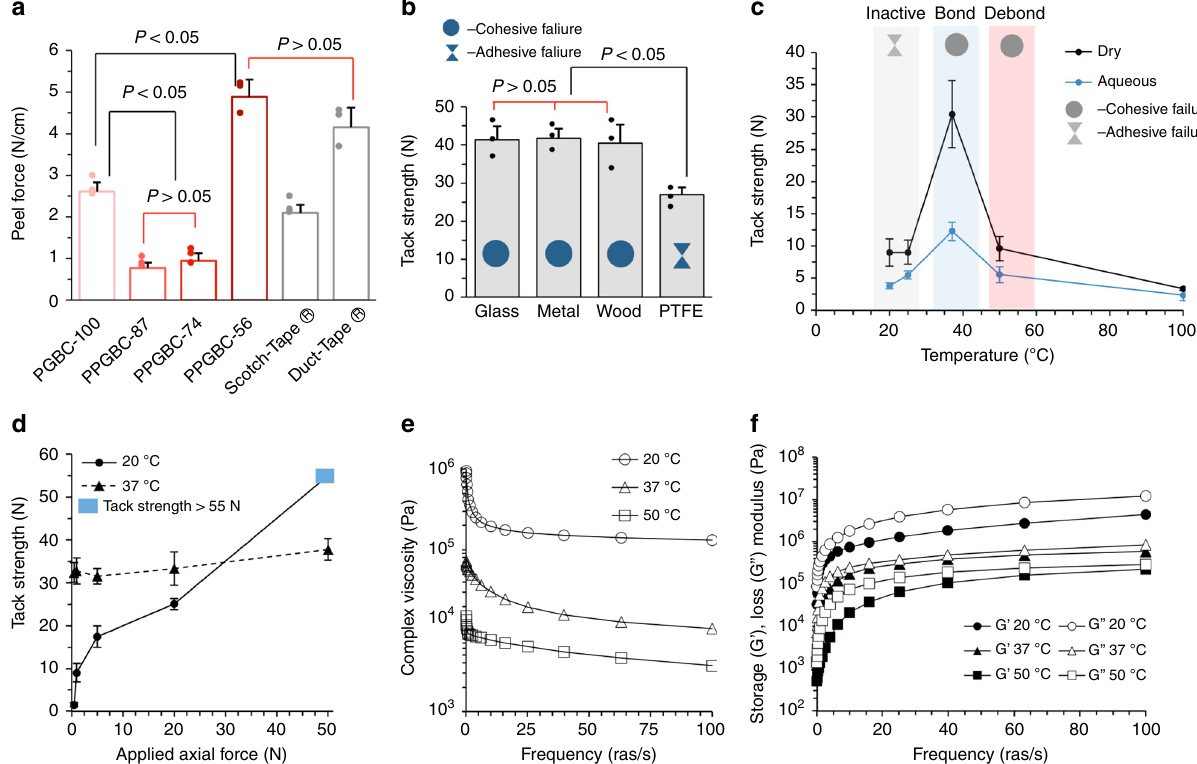
Fig. 3 Adhesive and rheometric properties of terpolymers under various conditions. a Peel testing (180°) at room temperature (22 °C) of viscous poly (propylene -co- glycidyl butyrate carbonate)s and commercial adhesives ( n = 3). b Tack strength of PPGBC-56 applied to four surfaces at room temperature ( n = 3). c Tack strength of PPGBC-56 with 1 Newton of applied axial force at different temperatures tested in atmospheric conditions and underwater ( n = 3). d Tack Strength vs. different applied axial pressure for PPGBC-56. e Frequency sweep of the complex viscosity ( η ) of PPGBC-56 at three different temperature ranges ( n = 3). f Frequency sweep of the storage (G ′ ) and loss (G ″ ) modulus of PPGBC-56 at 20, 37, and 50 °C. Source data are provided as a Source Data fi le for Figs. 3 – d. Error bars indicate mean ± s.e.m. and all signi fi cance testing was conducted using ANOVA.